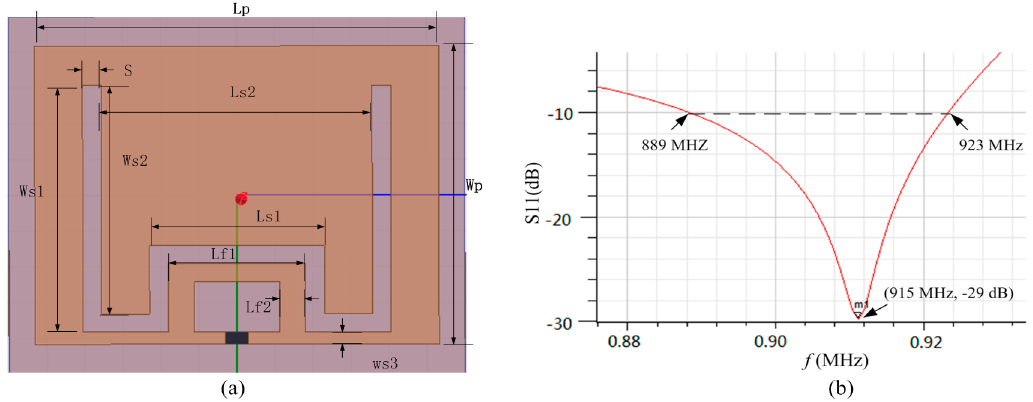
Figure 11. Proposed patch antenna: ( a ) antenna design; ( b ) return-loss plot. Table 1. Design parameters of the patch antenna.